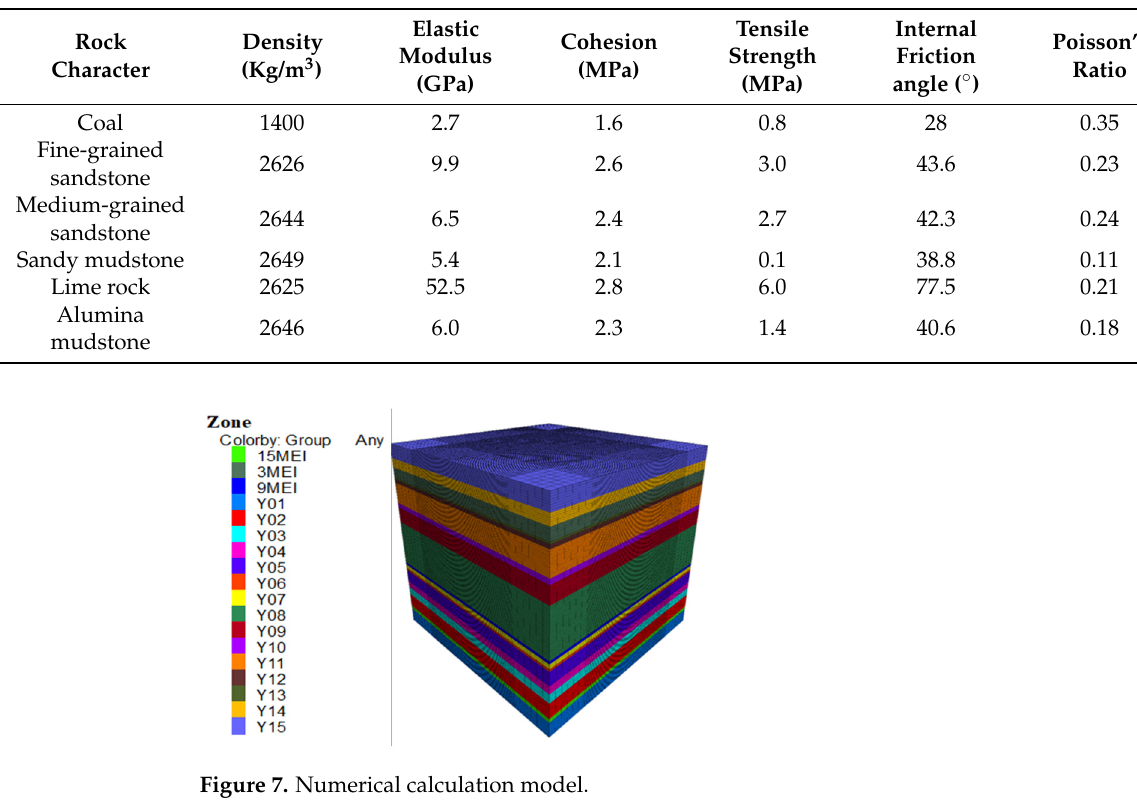
Table 3. Rock mechanical parameter table.